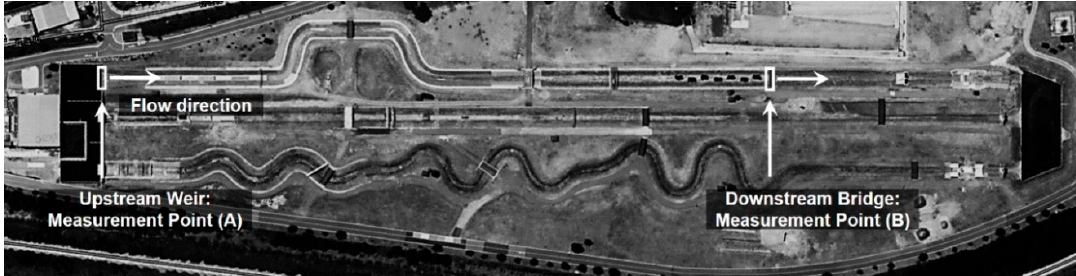
Figure 1. Stream-scale experiment channel of Korea Institute of Civil Engineering and Building Technology—River Experiment Center (KICT-REC).